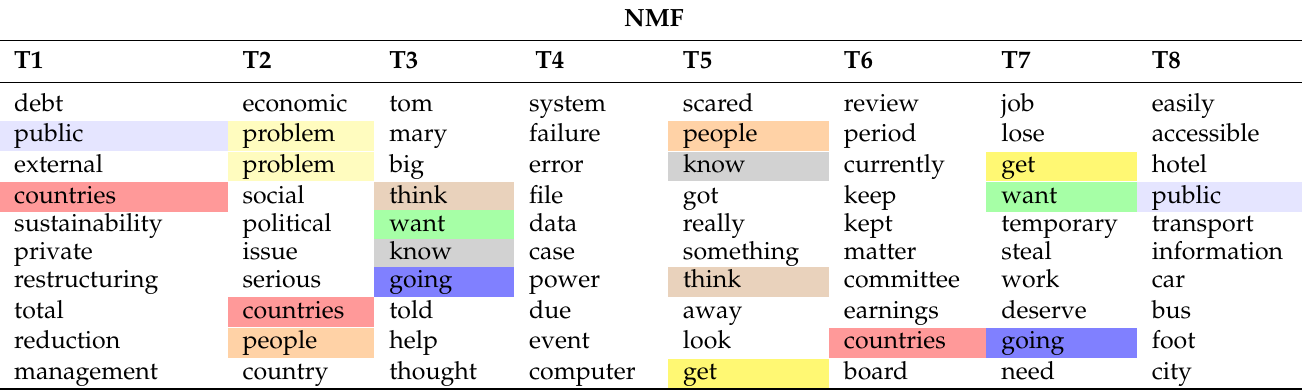
Table 3. Collection of topics and the top 10 keywords of the corresponding topic represented by the NMF model.